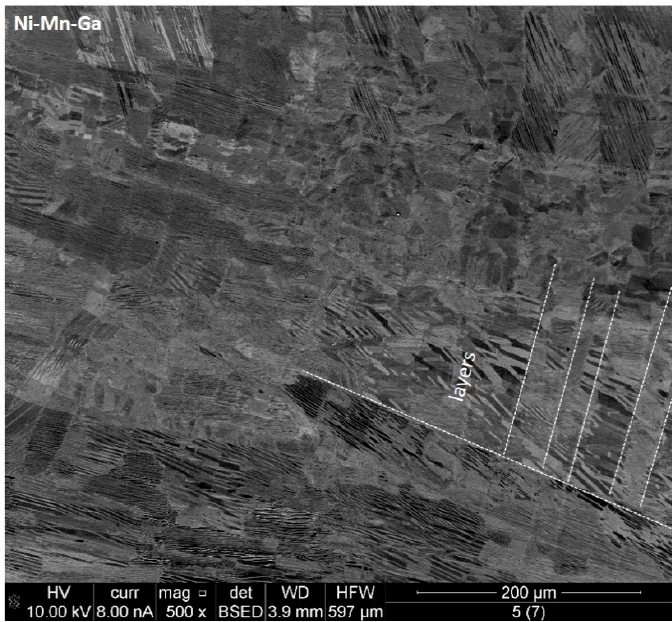
Figure 5. Backscatter electron (BSE) images of as laser melted Ni-Mn-Ga powders.